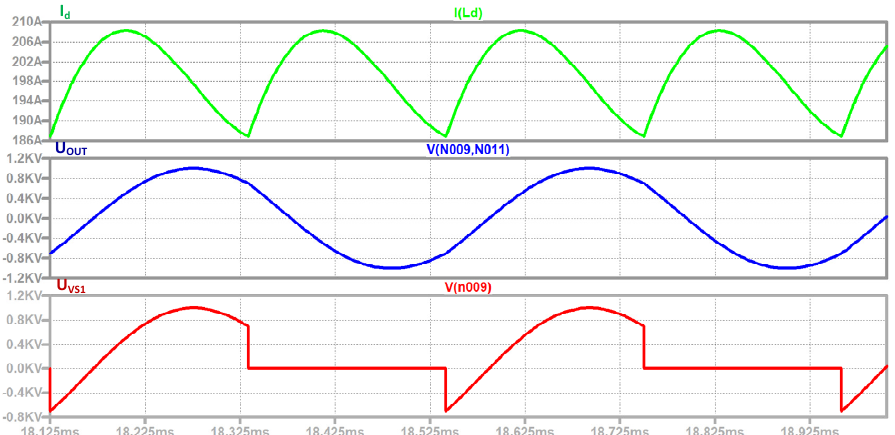
Figure 5. Time diagram of the input current—I d , output voltage—u OUT and voltage across thyristor VS 1 —u VS1 in the designed and simulated current source inverter. Table 1 compares the results calculated using the unified analysis and the current source inverter design methodology based on it with those obtained from the simulator and experiments. The values obtained from the simulation studies were determined using the basic functions of the computer simulator. Table 1. Output data and obtained results from simulation and experiment for full-bridge current source inverter.